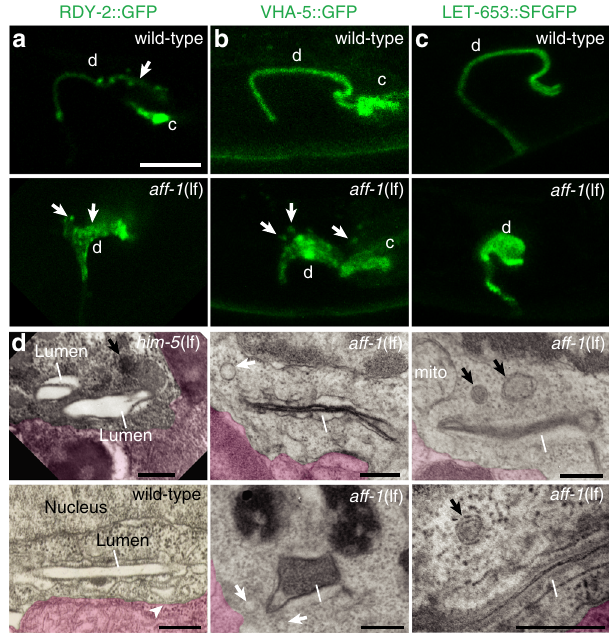
Fig. 3 aff-1 mutants accumulate apically marked vesicles. a Super-resolution stimulated emission depletion (STED) microscopy slices and b , c confocal Z-projections of L1 stage larvae: d, duct; c, canal. Apical markers are a tetraspan protein RDY-2 37 , b vacuolar ATPase subunit VHA-5 37 , and c luminal matrix protein LET-653 36 . In wild-type, apical signal is highly restricted to a region near the elongated lumen. aff-1 ( tm2214 ) mutants show a shorter and wider apical domain, with isolated puncta as shown by arrows. d TEM transverse slices of normal [ him-5 ( e1490 ) or N2] or aff-1 ( tm2214 ) L1 duct. Neighboring cells are false-colored in pink. Line indicates cuticle-lined lumen. Arrowhead indicates possible endocytic cup in wild- type. Small spherical vesicles (white arrows) and larger multi-membrane objects (arrows) are located near the lumen in aff-1 mutants. Scale bars, a – c = 5 μ m; d = 300